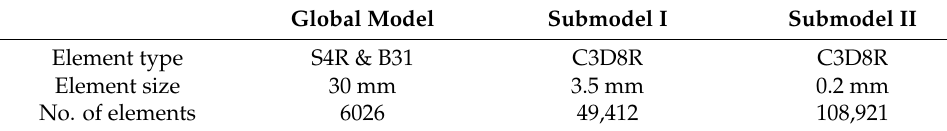
Figure 3. Finite element model separated into submodels.